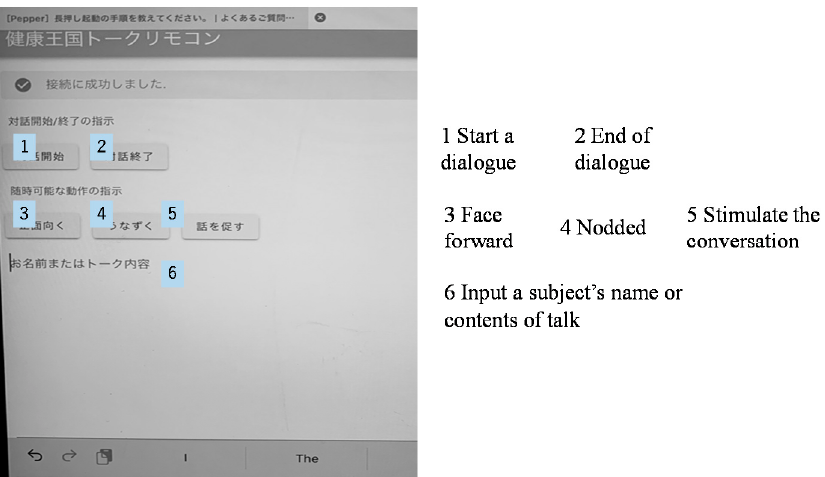
Figure 1. The display of the iPad mini remote control of the application program for an intentional conversation using the Pepper robot.